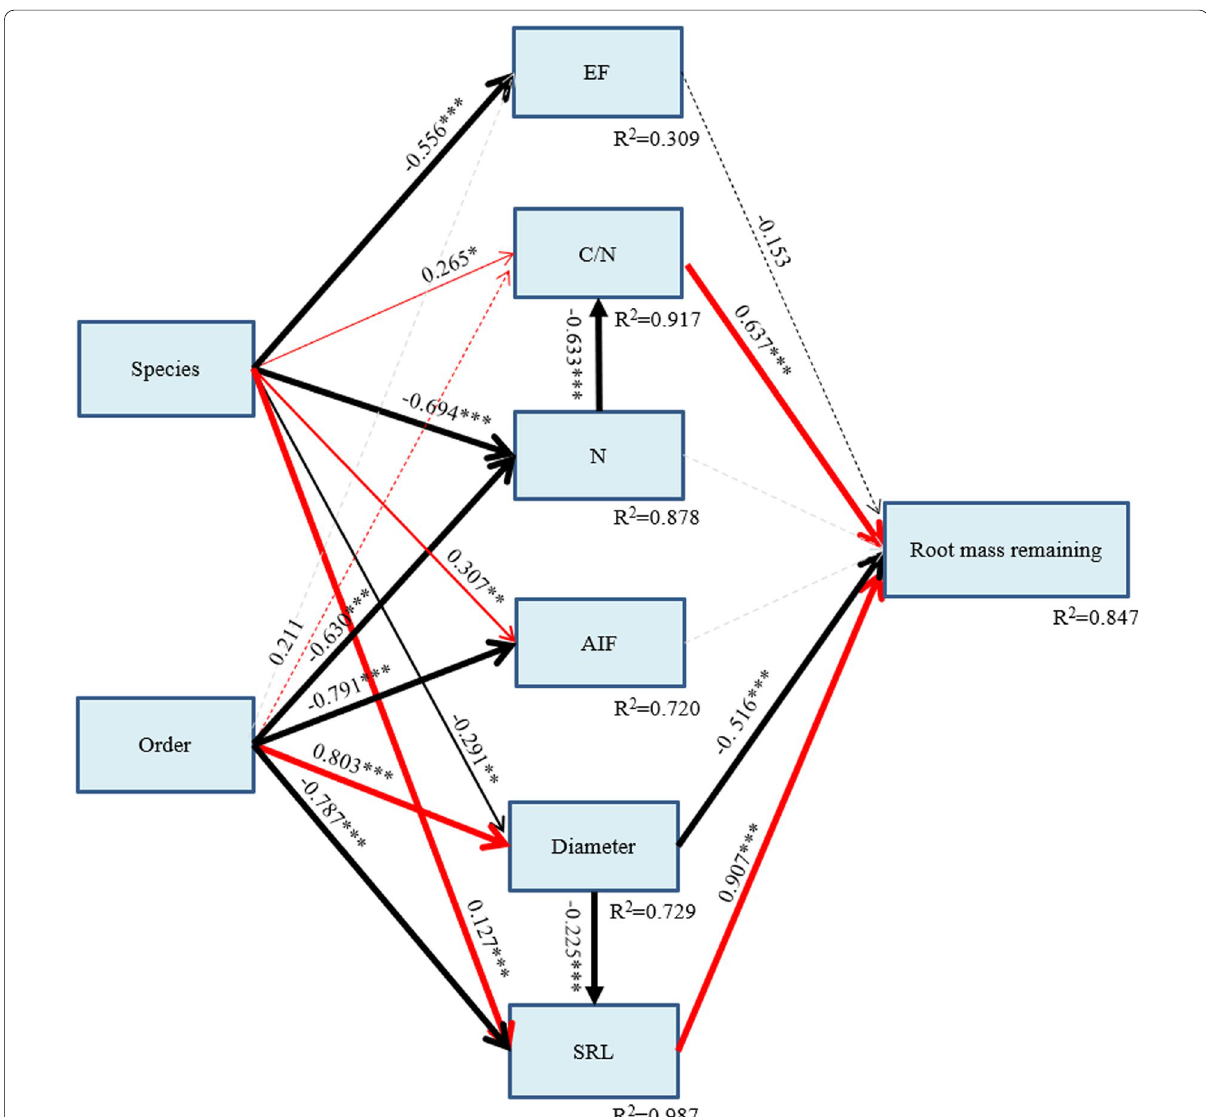
Fig. 4 Structural equation model of species and root-order effects on root decomposition. Relationships between species, root order and root chemical and morphological traits (EF, C/N, N, AIF, SRL and Diameter), and root mass remaining percentage. The final model fit the data well: χ 2 18.321, df 18, P 0.435, Akaike Information Criteria (AIC) 90.321, Root mean square error of approximation (RMSEA) = = = = adjacent to the arrows are standardized regression weights (* P 0.05, ** P < 0.01, *** P < 0.001). Red arrows represent positive relationships and black ≤ arrows represent negative relationships, respectively. The width of the arrows indicates the strength of the relationships. Red and black dashed arrows representing positive and negative nonsignificant paths are kept. Gray dashed arrows indicate nonsignificant paths removed to improve model fits. R 2 values below each variable indicates the proportions of variation explained by the model